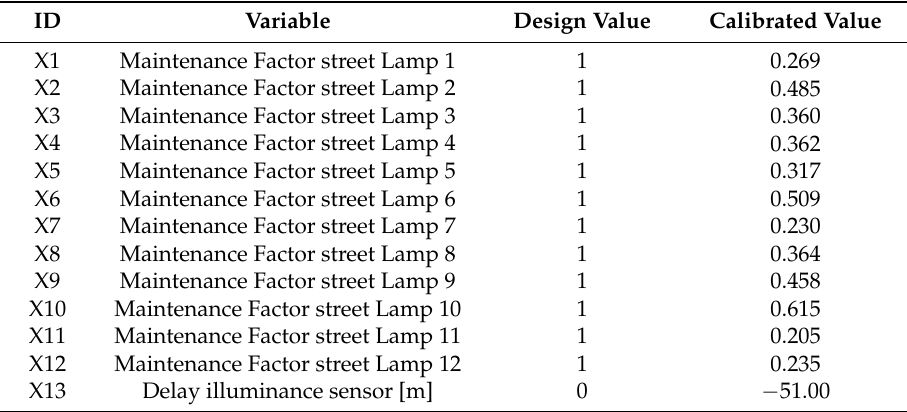
Table 3. Variables of the model for calibration process.